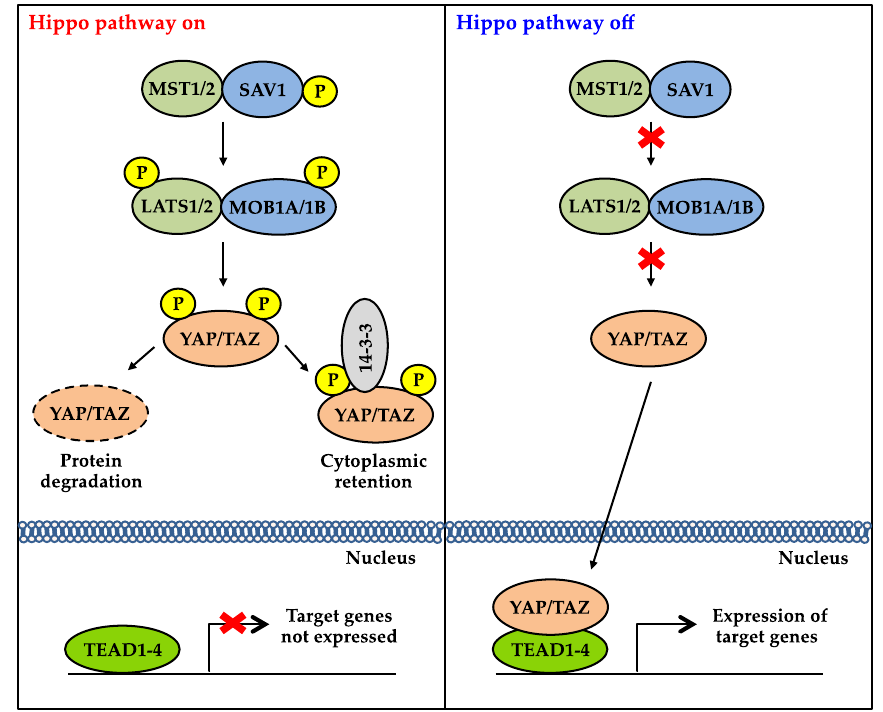
Figure 1. Schematic overview of the Hippo signaling pathway. (Left) When Hippo signaling is on, LATS1/2 phosphorylate YAP/TAZ, which leads to β-TrCP-mediated degradation of YAP/TAZ. Phosphorylation also promotes the retention of YAP/TAZ in the cytoplasm due to the interaction with 14-3-3. (Right) When Hippo signaling is inactivated, YAP/TAZ accumulate in the nucleus and interact with TEADs, resulting in the expression of YAP/TAZ target genes.